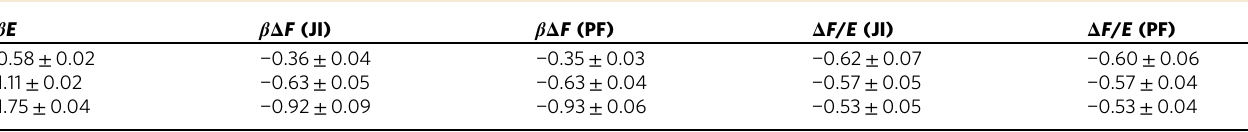
We show the estimation obtained using the Jarzynski identity (JI) and from a direct calculation of the partition function